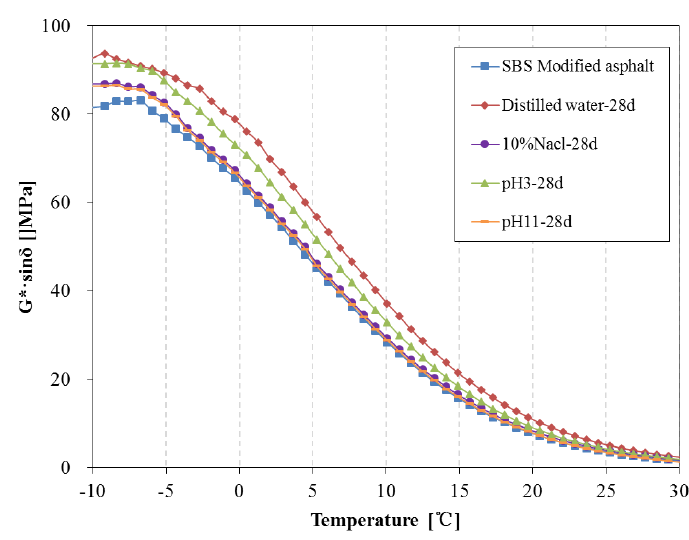
Figure 19. Fatigue factor of SBS modified asphalt before and after 28 days immersion.